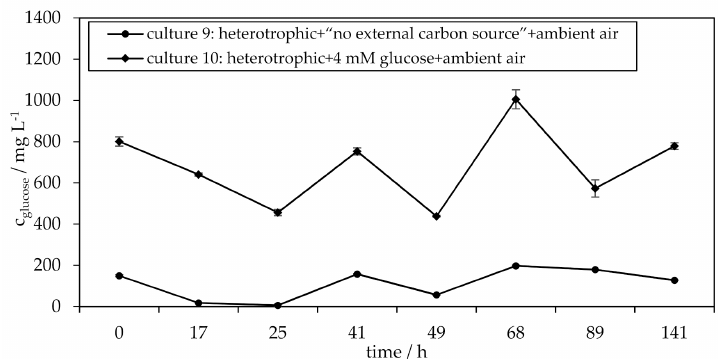
Figure 13. Time course of the glucose concentration in the medium of heterotrophic culture 9 (heterotrophic + “no external carbon source” + ambient air without external glucose) and culture 10 (heterotrophic + 4 mM glucose + ambient air with external glucose); error bars show ± SD, n =